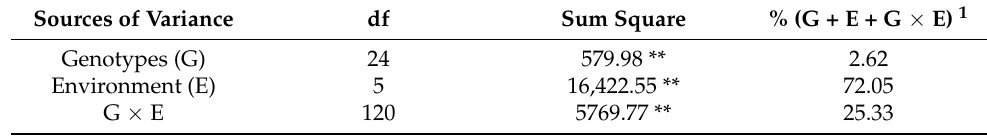
Table 4. Analysis of variance for grain yield of 25 genotypes studied across the six environments. Sources of Variance df Sum Square % (G + E + G × E) 1 Genotypes